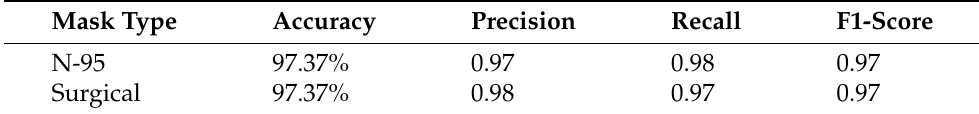
Table 11. Statistics using MobileNetV2 for types of face masks detection and classification.